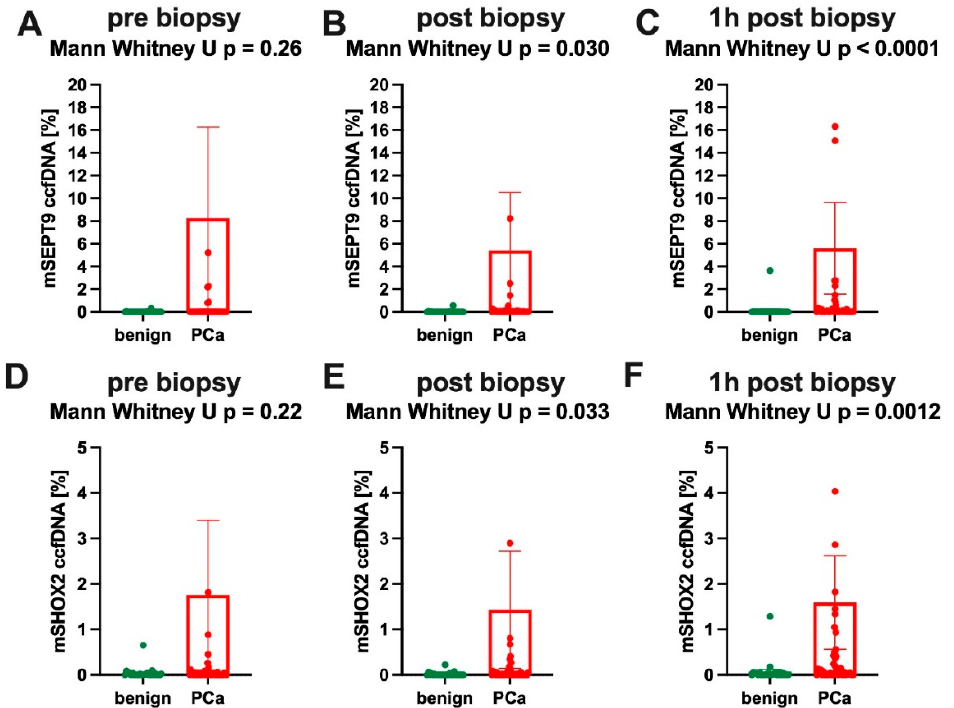
Figure 3. Time-dependent quantitative methylated SEPT9 and SHOX2 analysis during prostate biopsy. ( A – C ) show dynamic changes of mSEPT9 (methylated Septin 9 ) and ( D – F ) of mSHOX2 (methylated short stature homeobox 2 ) in ccfDNA (circulating cell-free DNA) during the course of prostate biopsy.